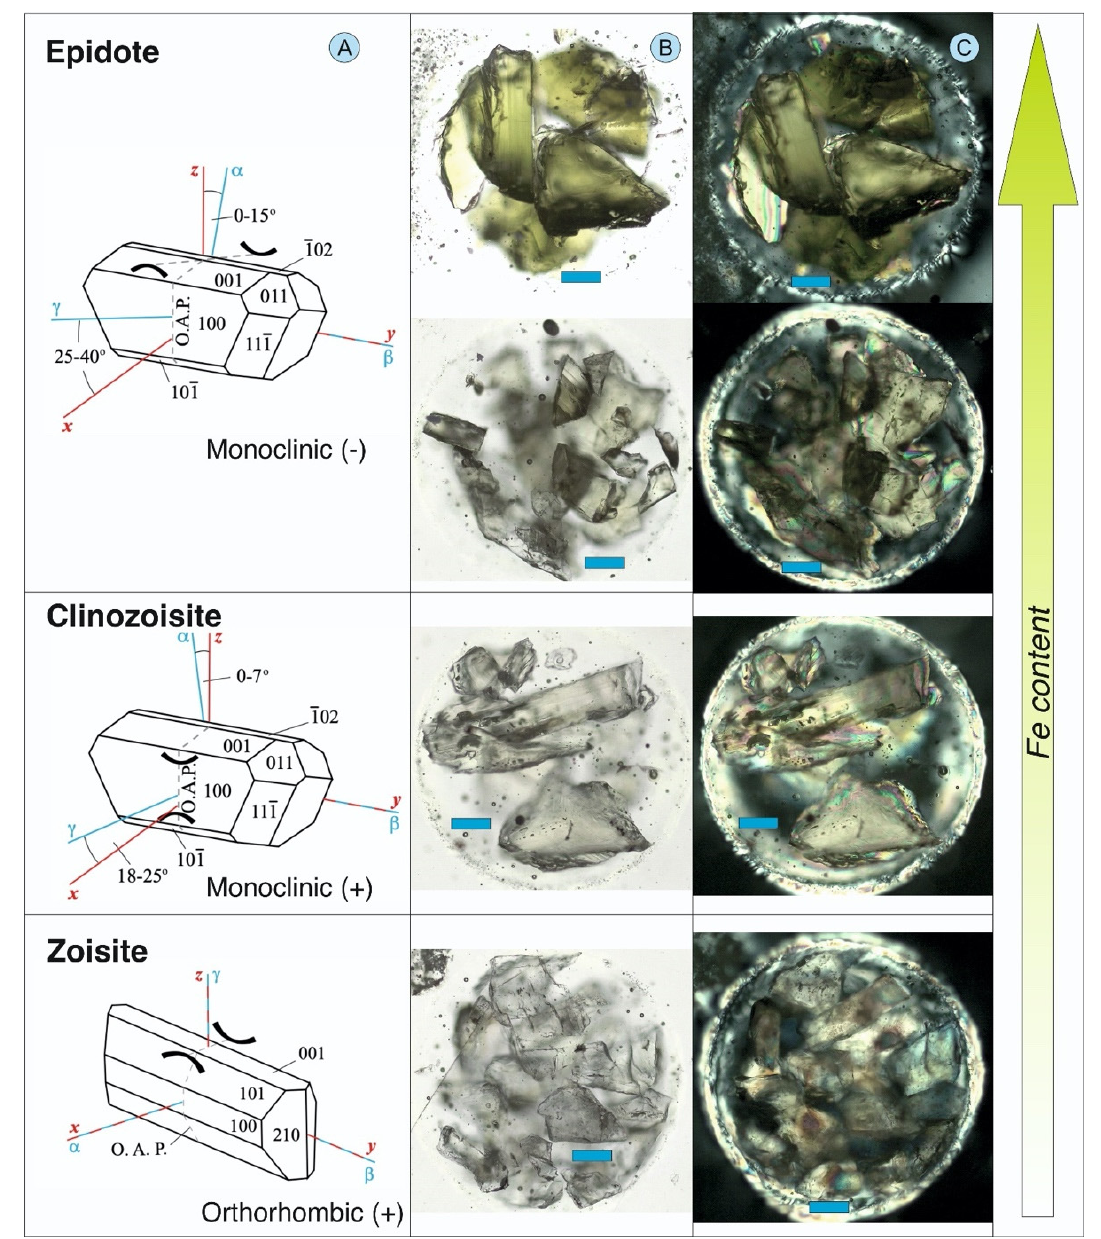
Figure 1. Optical features. ( A ) Epidote group minerals are biaxial with an optical axis perpendicular to the elongation of the crystal. The optical sign is negative in epidote and positive in clinozoisite and zoisite (modified after [63]). ( B ) Parallel-polarized light: pleochroism increases with iron content from colorless clinozoisite to yellowish green epidote. Zoisite is colorless. ( C ) Cross-polarized lights: birefringence increases with iron content in the epidote–clinozoisite series. Zoisite shows anomalous indigo-blue and yellow interference colors. Shown in ( B , C ) are fragments of standards E1, E3, C1, and Z. Blue bar for scale = 100 µm.